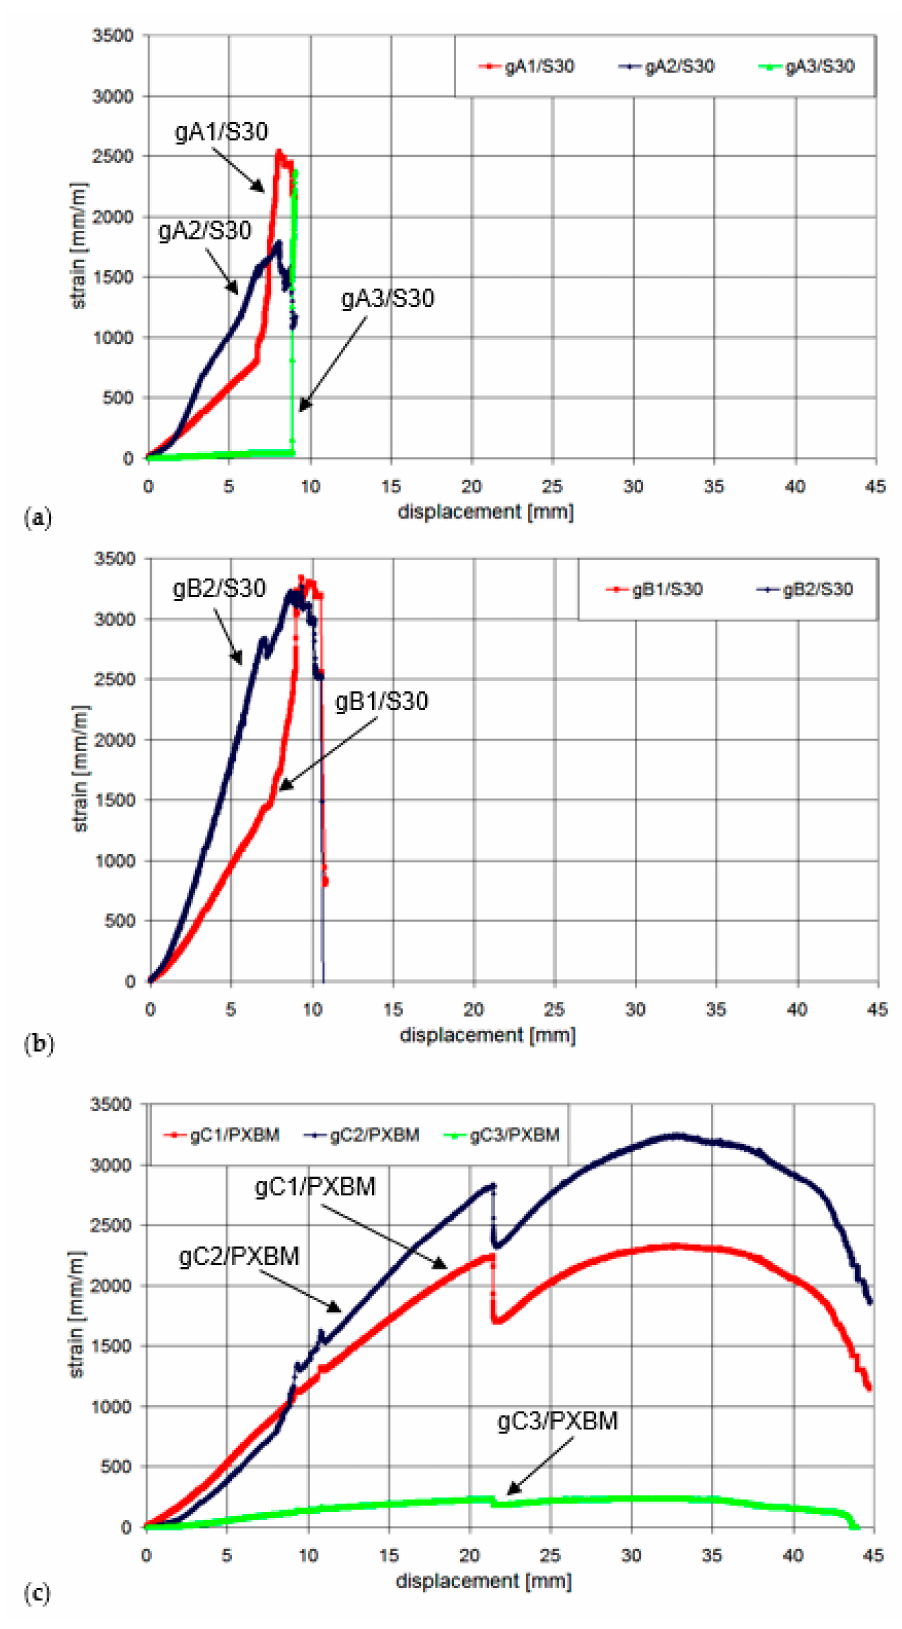
Figure 12. Changes of the laminate strains at the points ( a ) A/S30; ( b ) B/S30, and ( b )